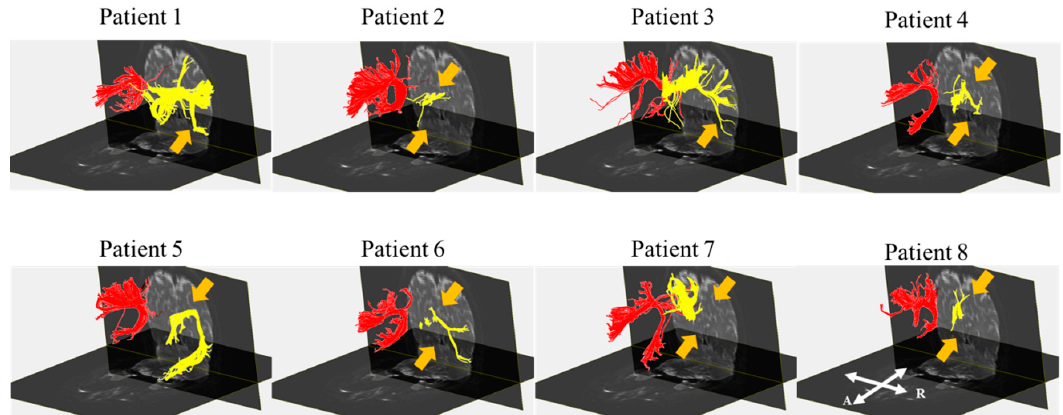
Figure 3. Diffusion tensor images for the bilateral SLFs of eight patients. Patients 2, 4, 6, 7, and 8 show an injury of both the dorsal and ventral pathways of the right SLF. Patients 1 and 3 show injuries in the ventral pathway of the SLF, and the SLF of patient 5 reveals damage in the dorsal pathway. Note: SLF, superior longitudinal fasciculus; yellow part; the right SLF, red part; the left SLF, R, right; A, anterior; orange arrow, injury site; “R” and “A” in patient 8 are reflected throughout the patient’s image.